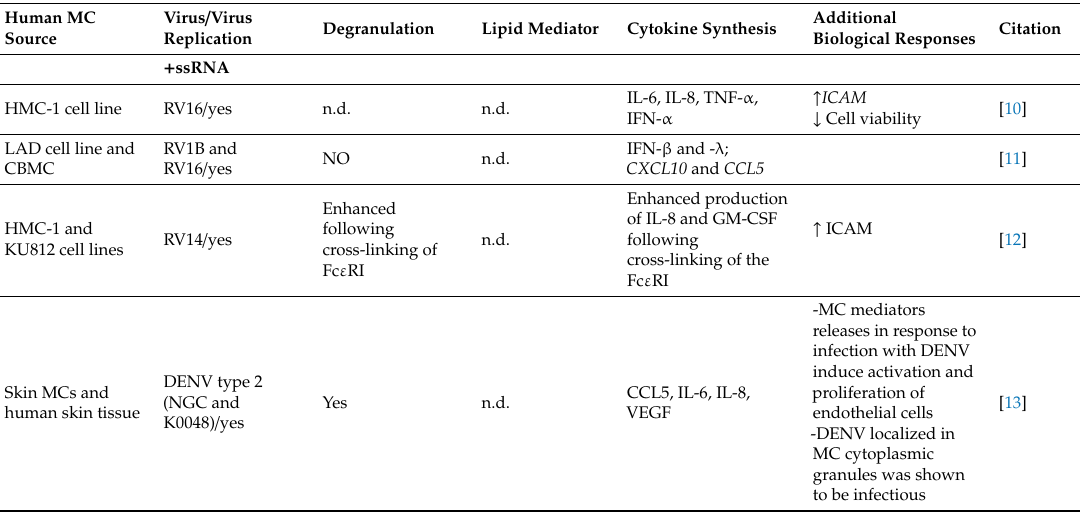
Table 1. Key in vitro studies of mast cell responses to viral